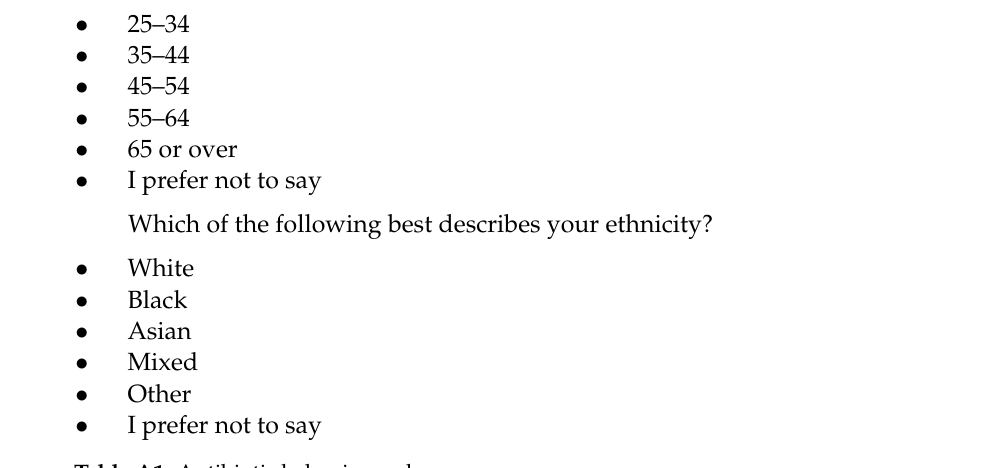
Table A1. Antibiotic behavior scale.